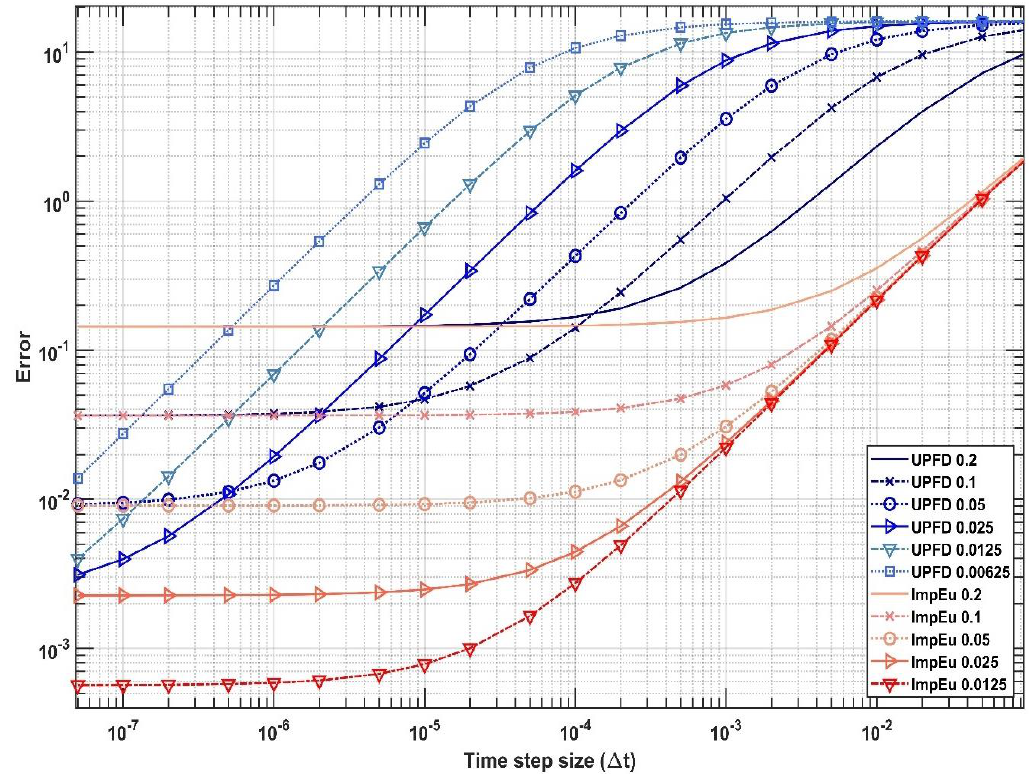
Figure 8. Errors as a function of the time step size for the UPFD and the implicit Euler (ImpEu) methods with different space step sizes in Experiment 3. ∆ x changes from 0.2 to 0.00625 and to 0.0125 for the UPFD and the implicit method, respectively.